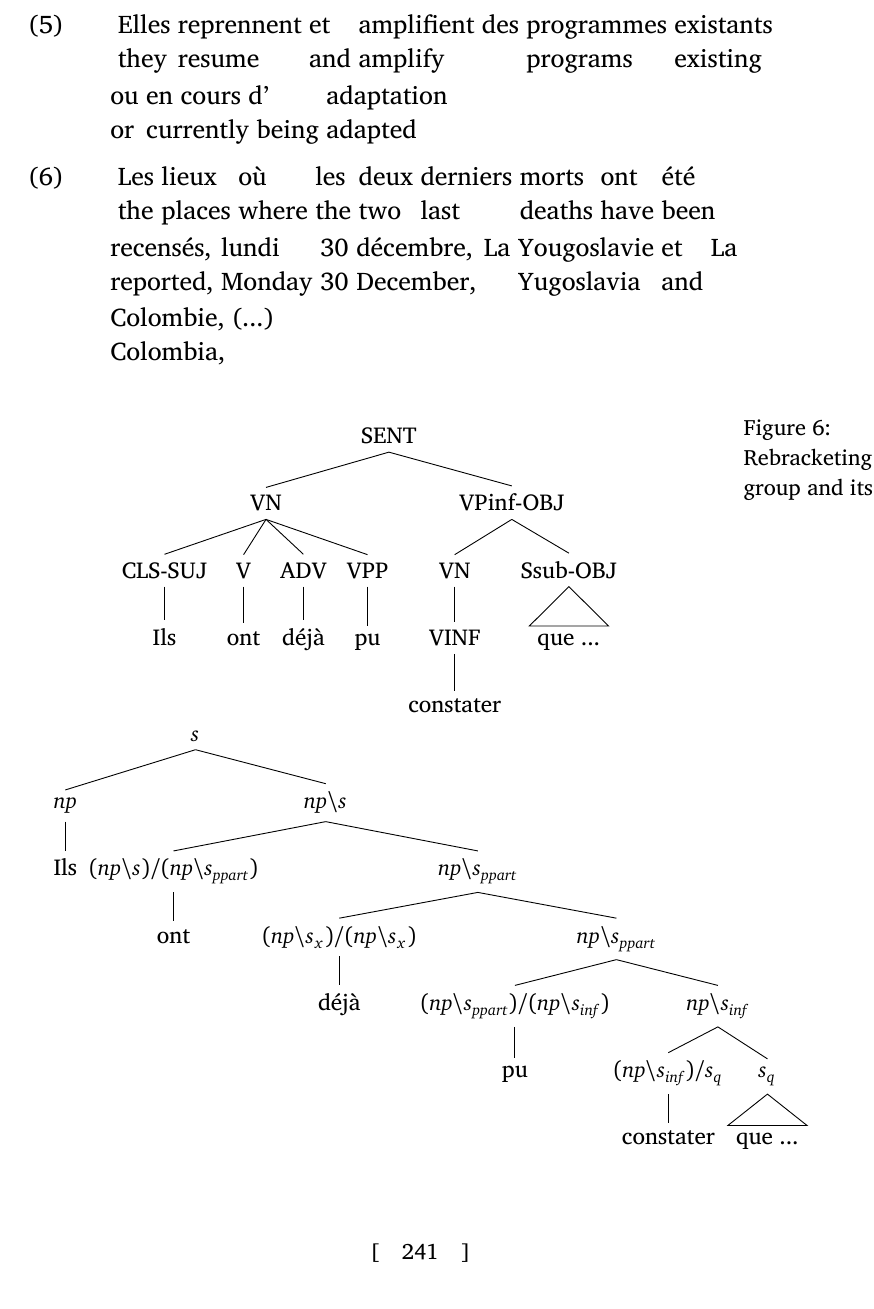
Figure 6: Rebracketing a verbal group and its